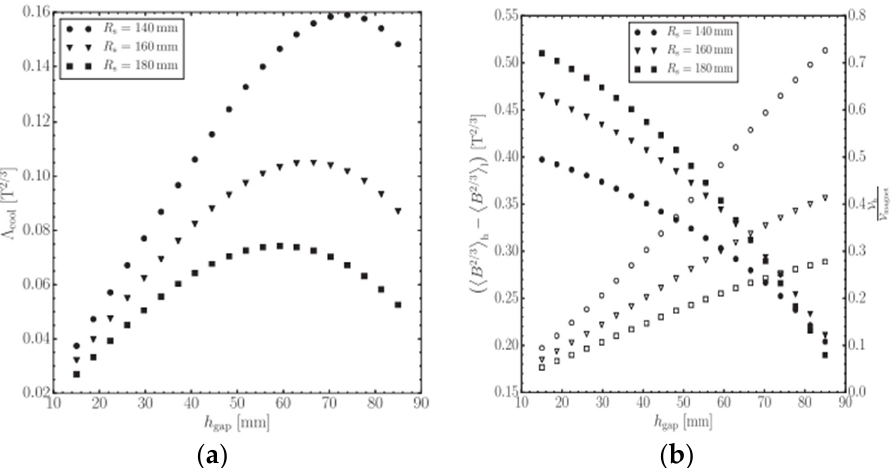
Figure 6. Influence of the air gap height on the magnetic circuit performance: ( a ) Λ cool (viz., the magnetic circuit characterization parameter); ( b ) each individual term which composes Λ (cid:3030)(cid:3042)(cid:3042)(cid:3039) [41].